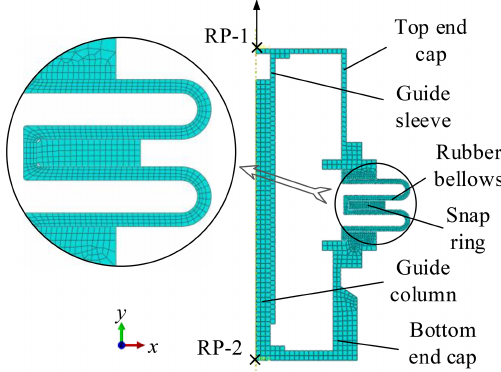
Figure 4. Finite element